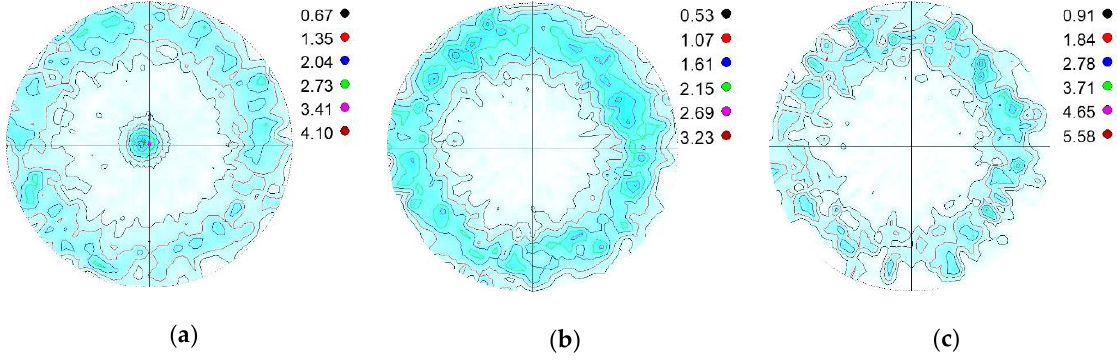
Figure 5. ( a ) γ{111}, ( b ) ε{002} and ( c ) α’{110} pole figures of Steel 0.0 7, tensile tested at 473 K [13].